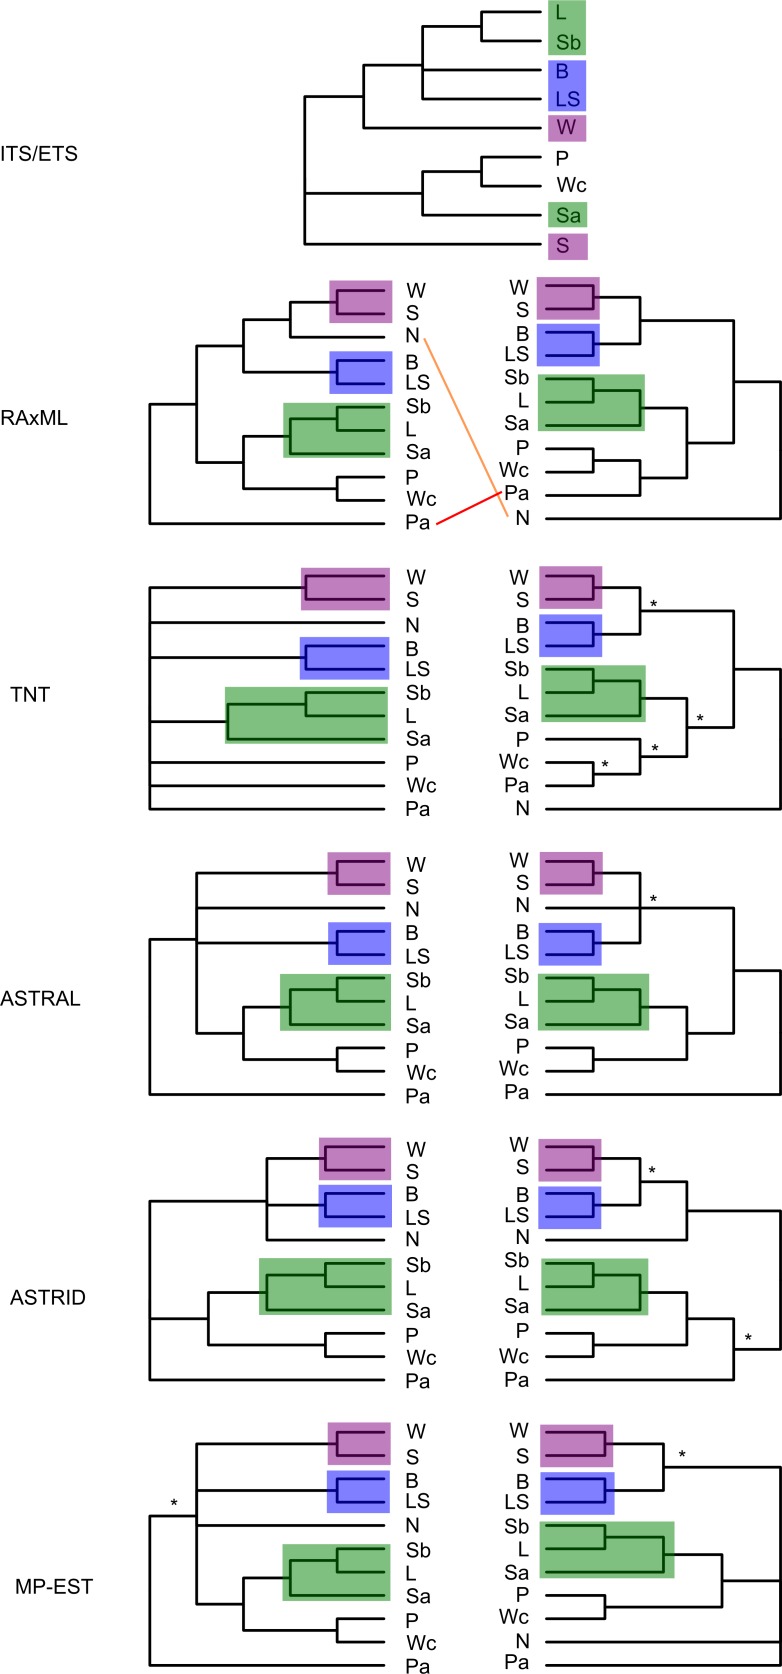
Topologies for the Triodia basedowii complex across analyses for two assemblies.0.88/0.91 (merged/unmerged) clustering threshold, 50% minimum taxon coverage (left) and 0.88/0.82 clustering threshold, 25% minimum taxon coverage (right). Branches with less than 80% support are collapsed. Asterisks designate clades not present in the alternate assembly. Clades consistent across analyses are highlighted. B: T. basedowii, L: T. lanigera, LS: T. "LSandy", N: T. "nana", P: T. "Peed", Pa: T. "Panna", S: T. "Shov", Sa: T. "shova", Sb: T. "shovb", W: T. "War", Wc: T. "wcoast". ITS/ETS results are from Anderson et al. [46].